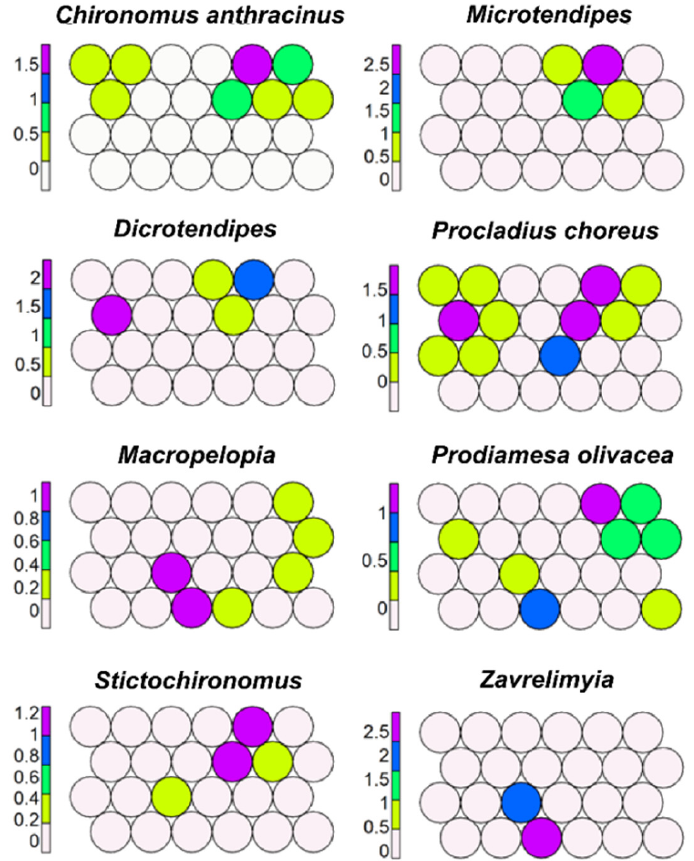
Figure 13. Supervised map of another eight morphotaxa using habitat as external factor. SSOM carried out using depth zone as factor well separated running waters and lake littorals from lake sublittoral and profundal zones (Figure 14). No morphotaxon showed to be restricted to lake profundal or sublittorals, while many morphotaxa were restricted to littoral zone. Only P. choreus , C. anthracinus , and P. olivacea were present in the profundal zone even if not exclusive to it (Figure 14).